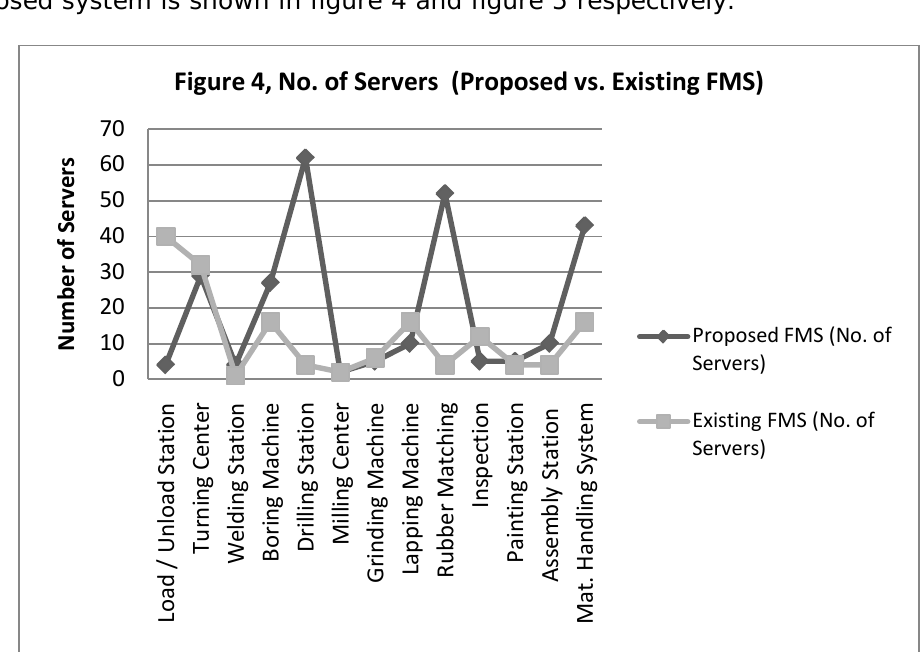
Figure 4. “No. of Servers (Proposed vs. Existing)”. Source: Own contribution.